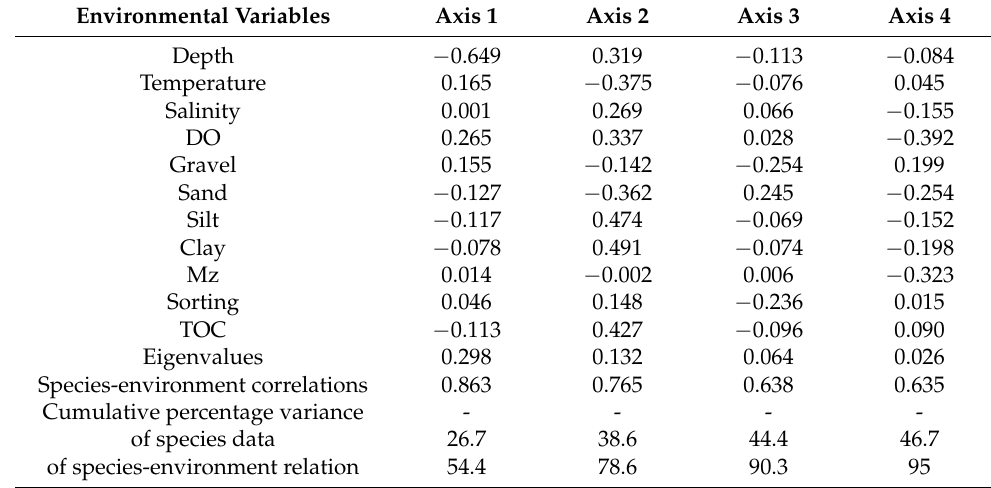
Table 6. Summary of the canonical correspondence analysis (CCA)